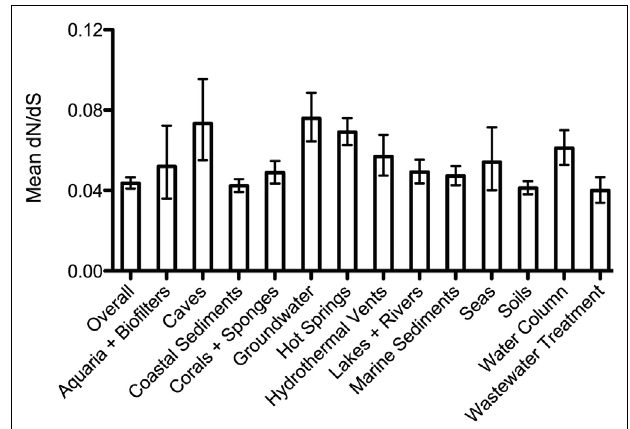
FIGUREA3 | Selective pressure (dN/dS) on amoA sequences from different habitats as calculated by the SLAC algorithm. Error bars represent 95% confidence